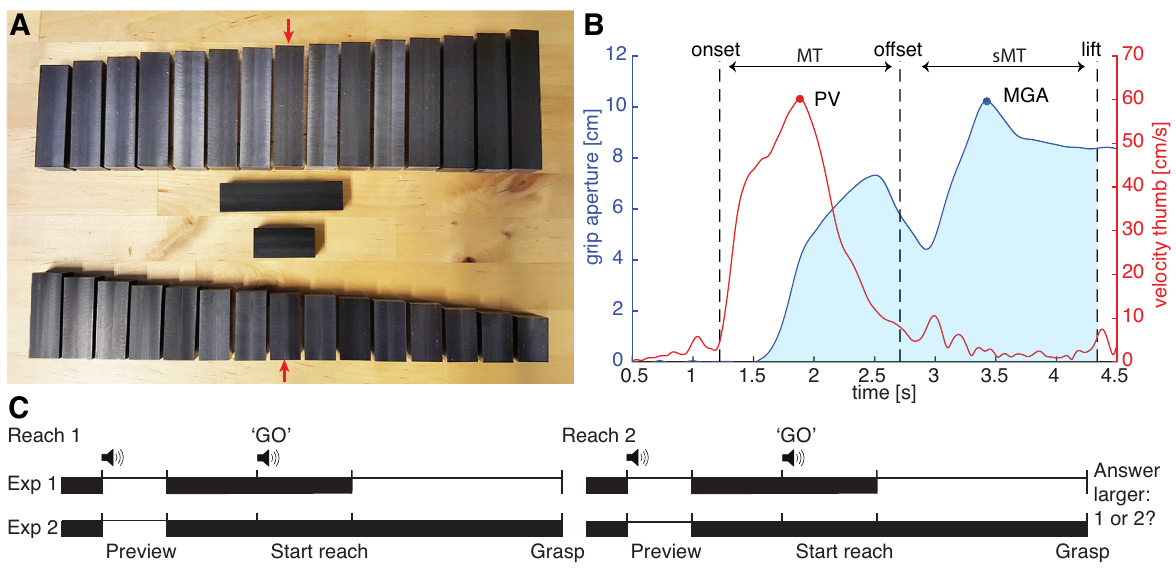
Fig 1. Experimental set-up and procedure. (A): Stimuli in the large (top) and small set (bottom). The reference object sizes are placed in the middle and are also indicated with a red arrow in each set. (B): Example of a single reach-to-grasp movement in Experiment 2, in the correction large condition. Note that this is an example with a large correction in grip aperture for illustrative purposes; many trials also had more smooth corrections. Solid lines indicate grip aperture (blue) and thumb velocity (red). Dashed lines represent time points of movement onset, movement offset and start of the lift, respectively. The parameters of interest are indicated: maximum grip aperture (MGA), peak velocity (PV), movement time (MT), secondary movement time (sMT) and summed grip aperture (shaded area). Note that the summed grip aperture was calculated over the curve plotted against the relative time (see Fig 4). C : Experimental time-line in Experiment 1 and 2 of 1 trial, consisting of 2 reaches. White and black parts indicate availability of visual information, i.e. when goggles are open and closed, respectively. First, a preview is shown with a warning tone. Next, after participants hear the ‘GO’ signal, they can initiate their reach-to-grasp movement. Vision is restored only in Experiment 1. After two reaches, participants indicate which of the two grasped objects was